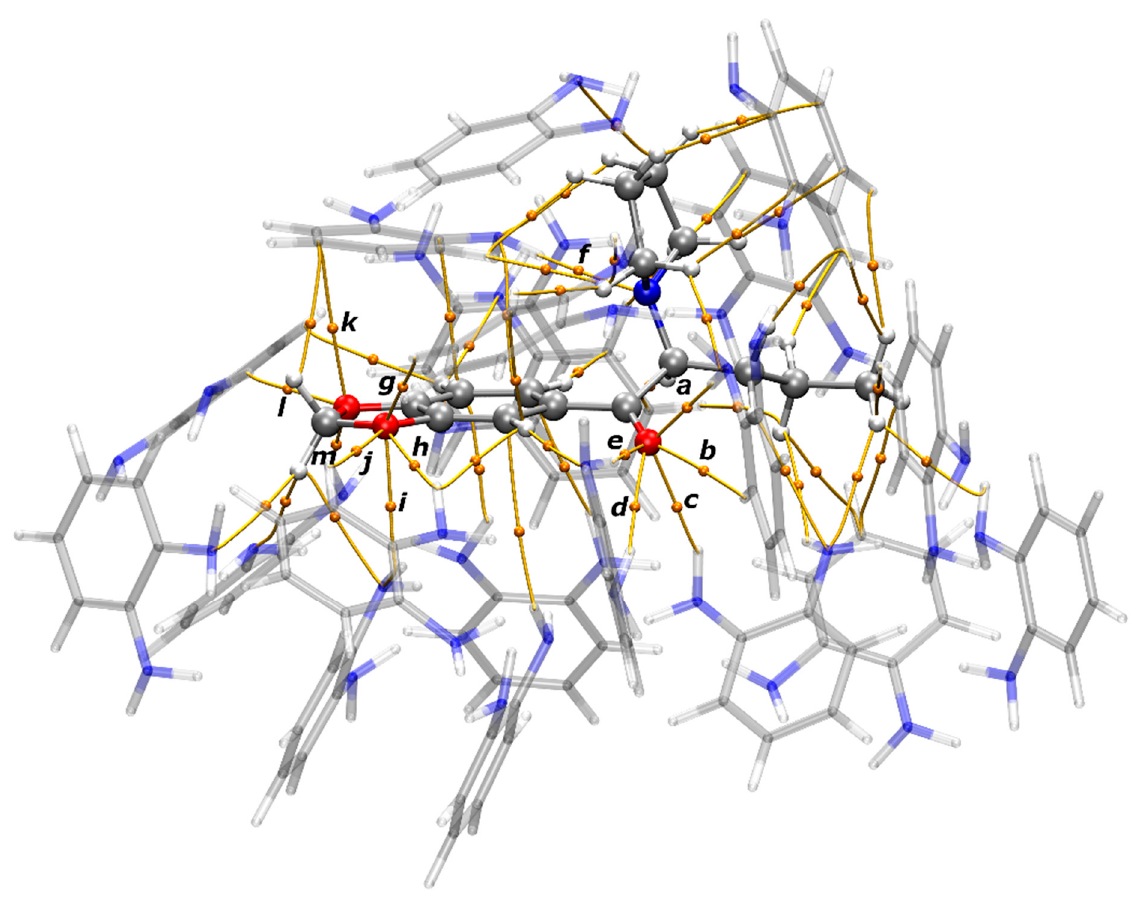
Figure 5. AIM molecular graph of the MIP pre-polymerization cavity with MDVP and 20 o -PD monomers. Orange lines are the Bond Paths (BP) that connect two attractors, and the orange spheres are the Bond Critical Points (BCP).